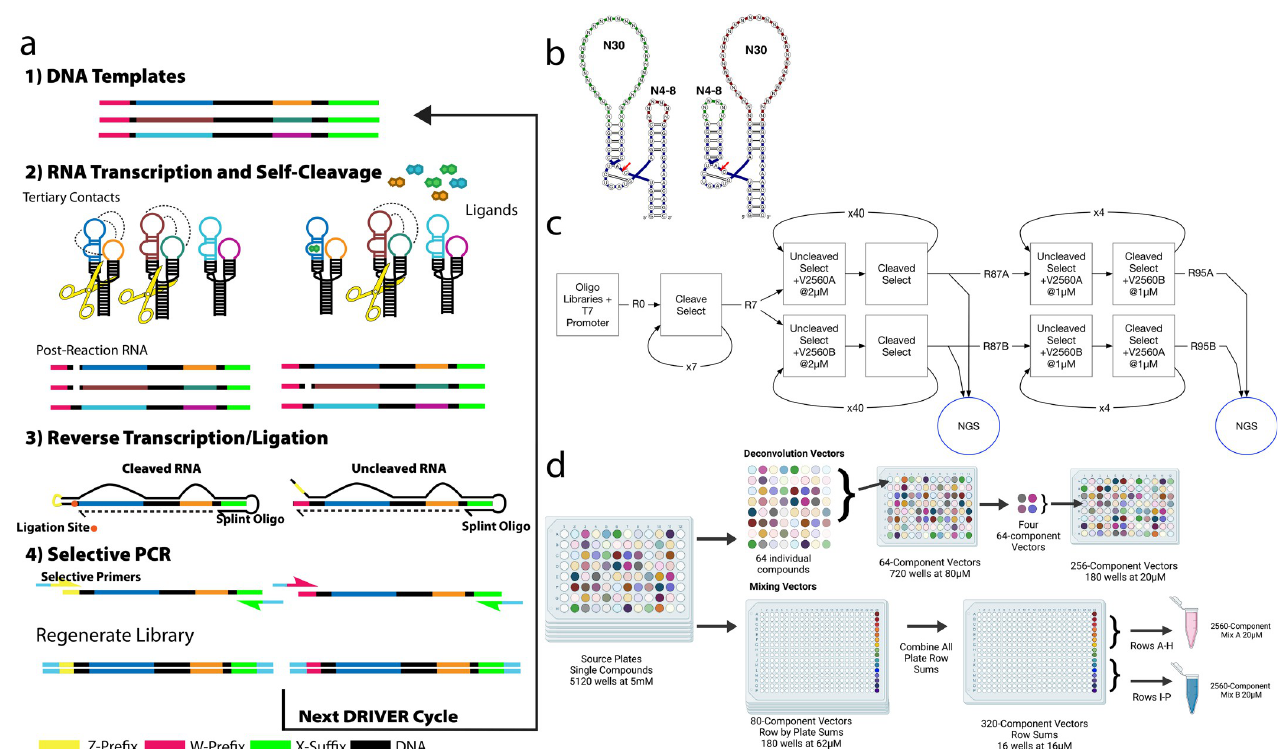
Fig 1. DRIVER overview and small molecule library setup. (a) Overview of DRIVER process. Sequences are transcribed in the absence or presence of ligands and allowed to self-cleave. An individual sequence is then either in a cleaved or uncleaved state. At this stage the RNAs are mixed with a splint oligonucleotide whose 3’ end acts as a reverse transcription (RT) primer. Following RT, the splint oligonucleotide’s 5’ end can anneal to the 3’ end of the cDNA corresponding to the cleaved sequences such that efficient ligation of a new prefix occurs for the uncleaved sequences. Following RT and ligation, the two prefixes can be used to distinguish between cleaved and uncleaved sequences–either for library regeneration or for quantification. (b) Secondary structure representation of general RNA biosensor library design with the loop randomizations indicated. N6 small loops and N30 large loops are shown. (c) DRIVER selection was performed for 95 rounds of selection followed by NGS analysis of products using CleaveSeq. (d) Source plates containing 5 μ l per well of 5120 compounds at 5 μ M in DMSO were reformatted to form two selection mixtures, V2560A & V2560B, and 180 256-component mixtures (V256-1-1 to V256-9-20).